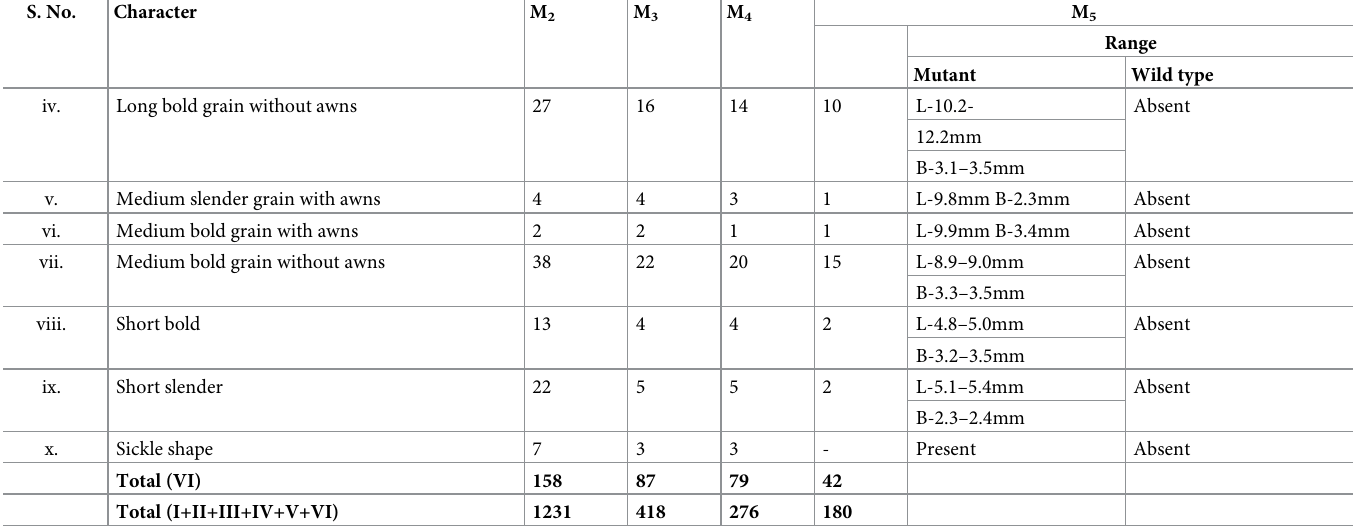
Variations in panicle emergence Complete panicle emergence (CPE) and Elongated Upper Internode (EUI) are two major traits that were studied under the category of panicle emergence. In this category, we identified 182 mutants (1.72% of the population) of which CPE mutants were more in number (1.47% of the population) and the EUI mutants were less frequent (0.25% of the population). The CPE mutants exhibited 2.0 to 2.5cm of panicle exertion and thus no panicle choking (Fig 2G)